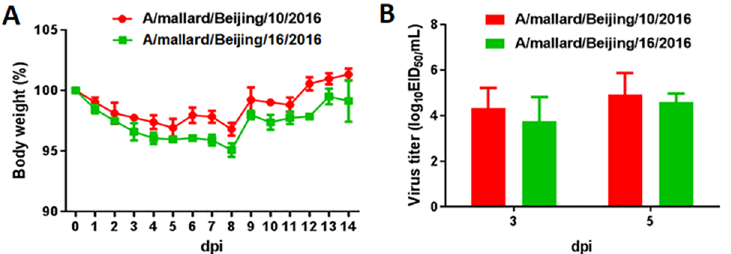
Fig 6. Weight loss and lung virus titration in mice inoculated with H4N6AIVs. Six-week-old female BALB/c mice (n = 3 mice/group) were inoculated i.n. with 10 6 EID 50 of virus. The body weights of inoculated mice were measureddaily and are representedas percentages of weight on the day of inoculation (day 0). The averages for each group are shown (A).The lungs of each mouse in each group were collectedat 3 and 5 dpi, respectively, for virus titration